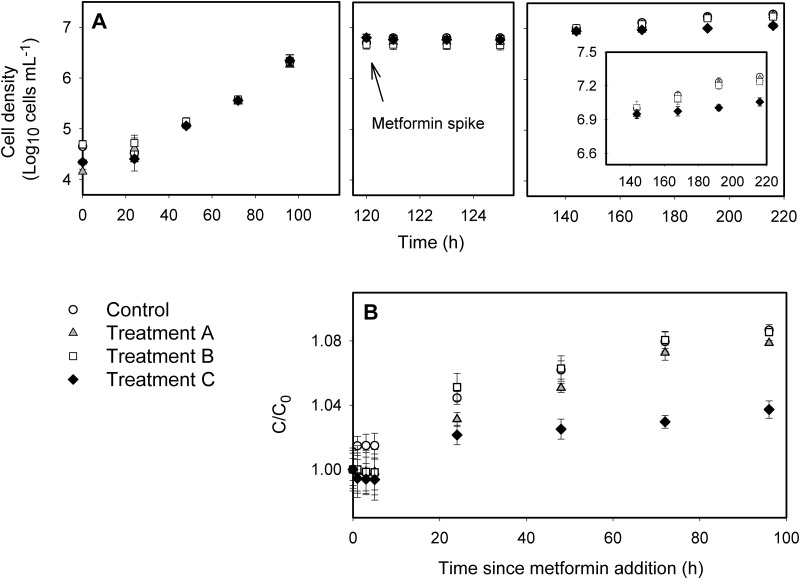
Algal growth curves (in log values) at different metformin concentrations.(A) Culture densities in Chlorella vulgaris in four triplicate cultures (three treatments and a control); first panel tracks cell densities over 96 h prior to a spike of three concentrations of metformin at 120 h, indicated in the second panel. Short-term changes in cell density were tracked for 5 h (120–129 h). Third panel shows cell densities at 144 h (24 h post-spike), 168 h (48 h post spike), 192 h (72 h post-spike), and 216 h (96 h post spike). (B) Ratio of cell density determined after inoculation relative to initial value (C/C0, where C0 = initial concentration at time = 120 h). Error bars represent ± 1 standard deviation.